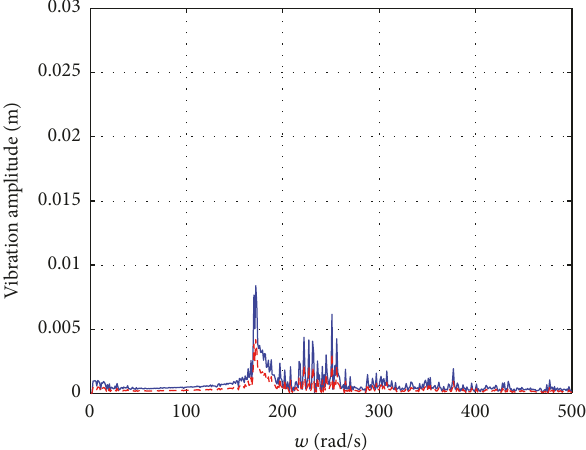
Figure 14: Comparison of two control effects (node